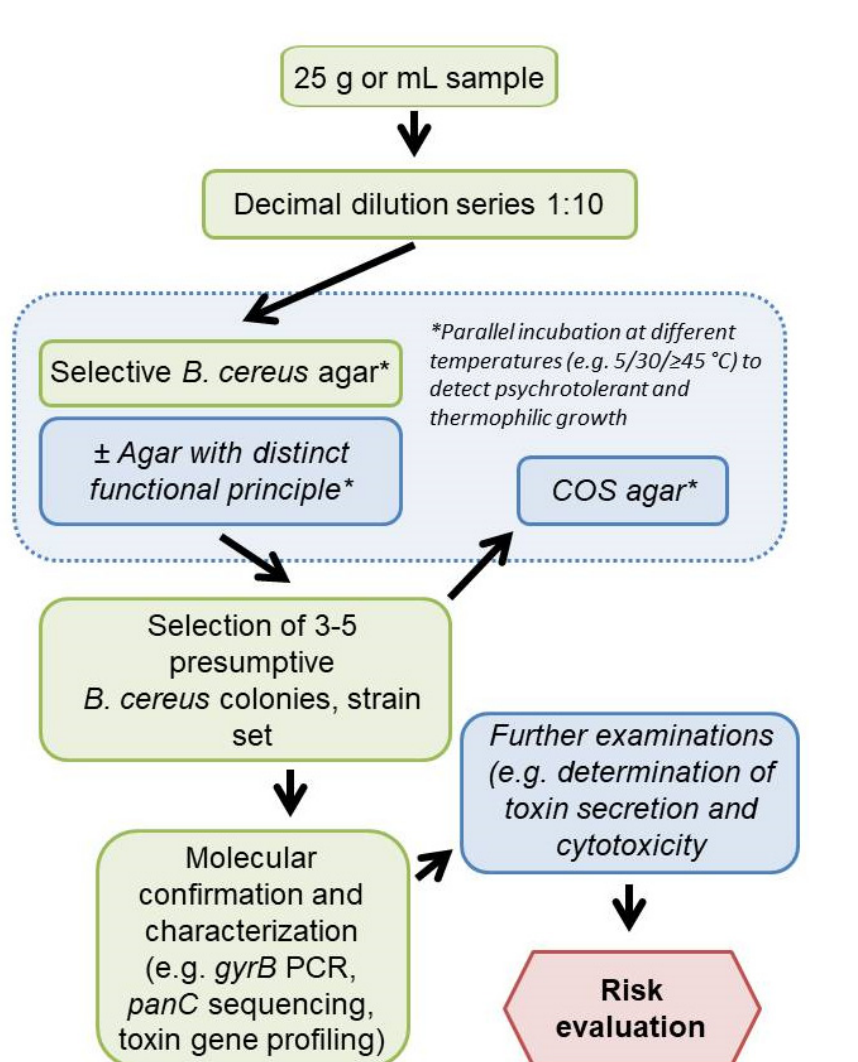
Figure 7. Proposed workflow for Bacillus cereus sensu lato analysis performable in routine food analysis (Italic—optional steps). COS, Columbia agar plus 5% sheep blood. *, parallel incubation at different temperatures to detect psychrotolerant and thermophilic growth.